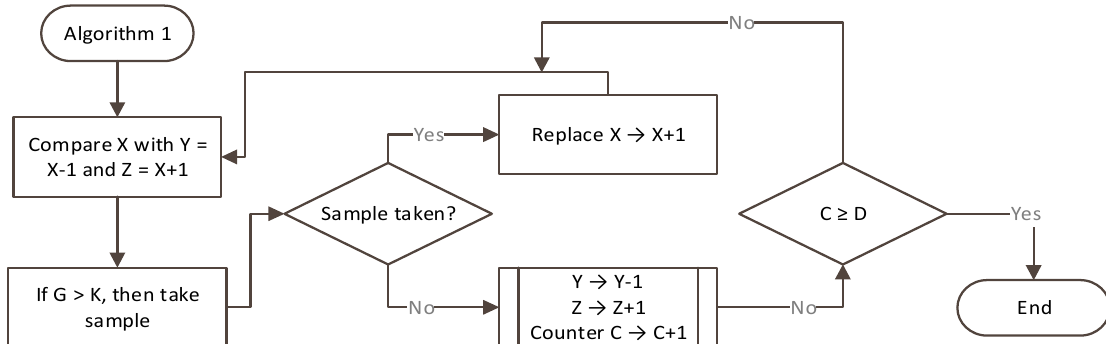
Figure 2. Flowchart of Algorithm 1, which takes samples based on pre-defined fine-mode method (FM) and coarse-mode method (CM) threshold values against neighboring data points.